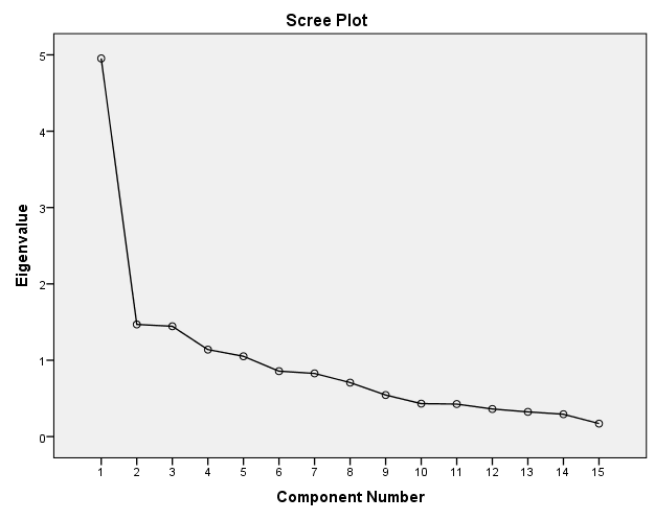
Figure 2. Scree plot for Financial Literacy construct.